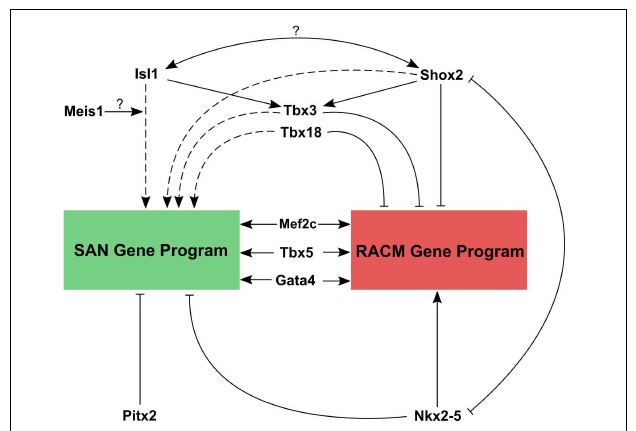
FIGURE 5 | Working model for transcriptional regulation in pacemaker cells. Transcriptional control of the SAN gene program and right atrial cardiomyocyte gene program are contrasted. Both tissues require the cardiac factors Mef2, Gata4, and Tbx5 to active cardiac gene expression. However, reciprocal repression of SAN genes by Nkx2.5 and atrial genes by Tbx3, Tbx18, and Shox2, along with activation of SAN genes by Isl1 (with possible interacting partners) allows for cell type specific gene expression patterns. Question marks indicate a hypothesized interaction that has not been tested yet. Solid lines represent direct promotion/inhibition and dashed lines represent either direct or indirect promotion/inhibition.